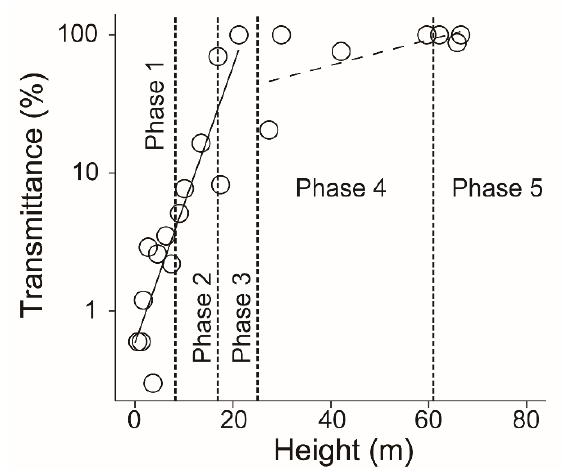
Figure 3. Relationship between height (x) and ln(%TRANS) (y). Lines indicate linear piecewise regression results; solid lines denote significant relationships ( P < 0.05), and broken lines denote nonsignificant relationships. Phase partitions were determined based on the results of multivariate regression tree (MRT). Note that a natural log scale is used on the Y-axis.